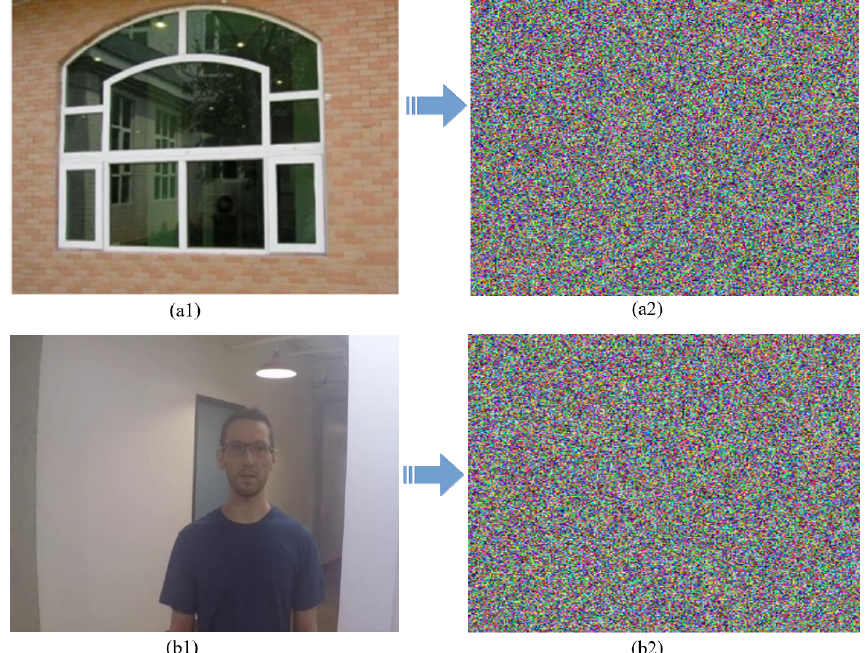
Figure 12. Visual Assessment: ( a1 ) A plain image of a window, ( a2 ) scrambled version of plain image ( a1 ) which gives no clue about it, ( b1 ) a clear input frame containing a person, ( b2 ) encrypted version of ( b1 ) which gives no information about it.